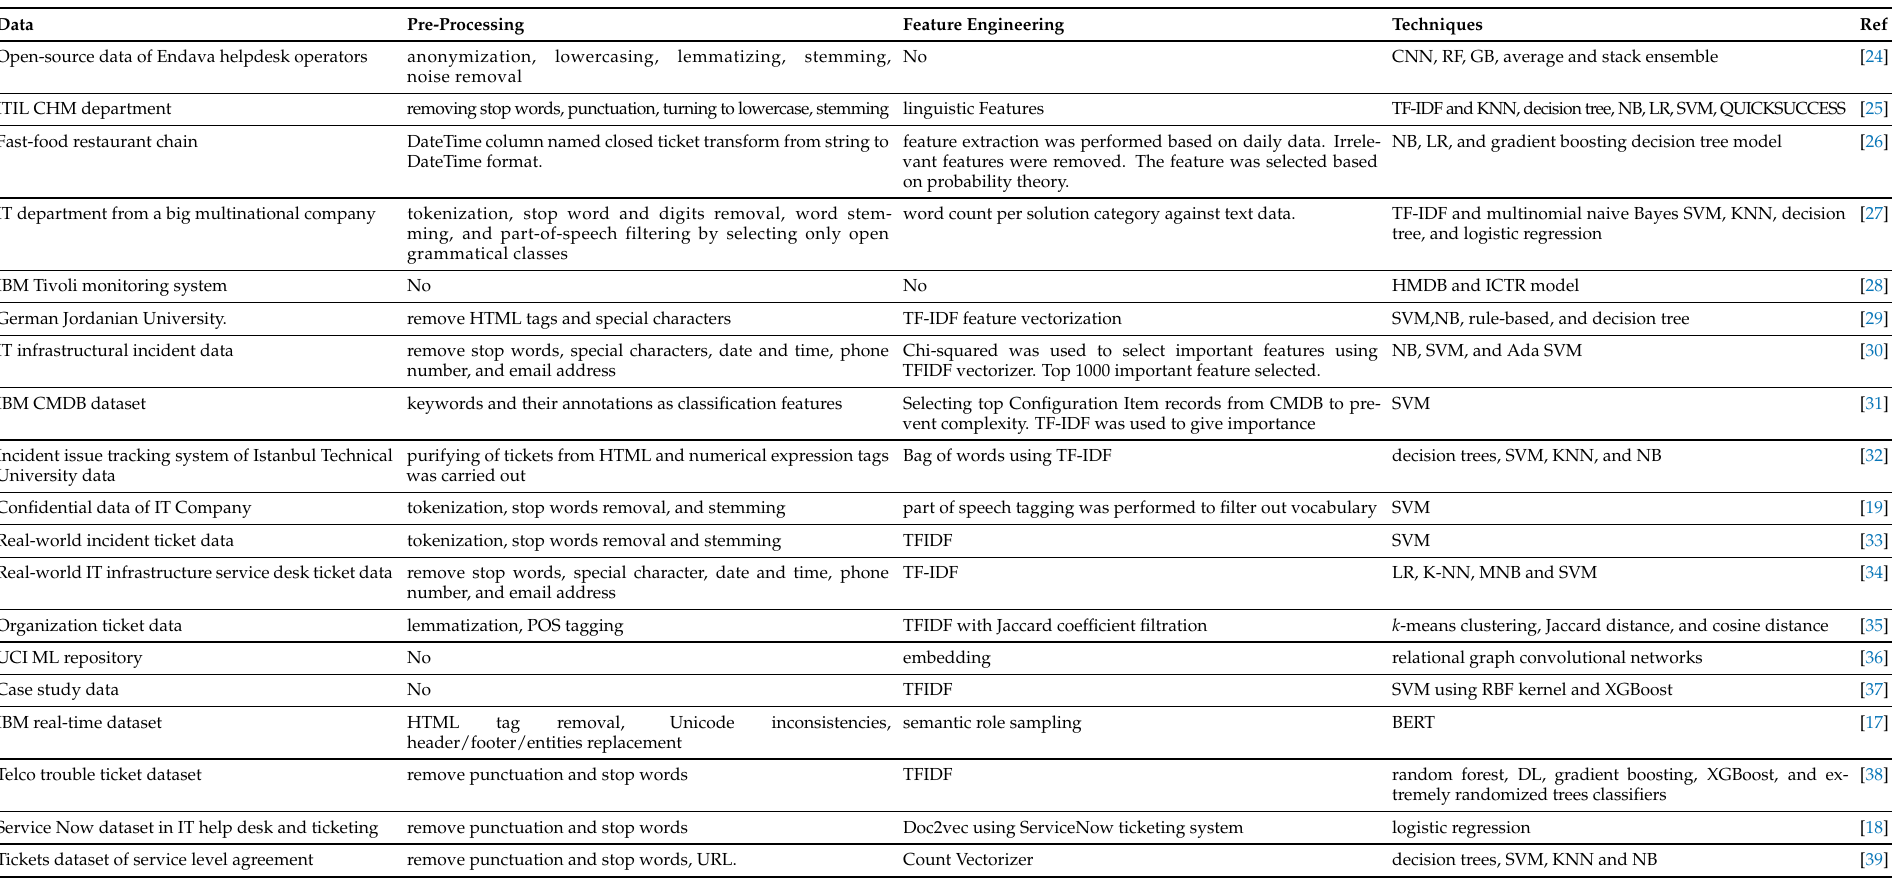
Table 1. Existing implementations of automated IT incident prediction utilizing AI